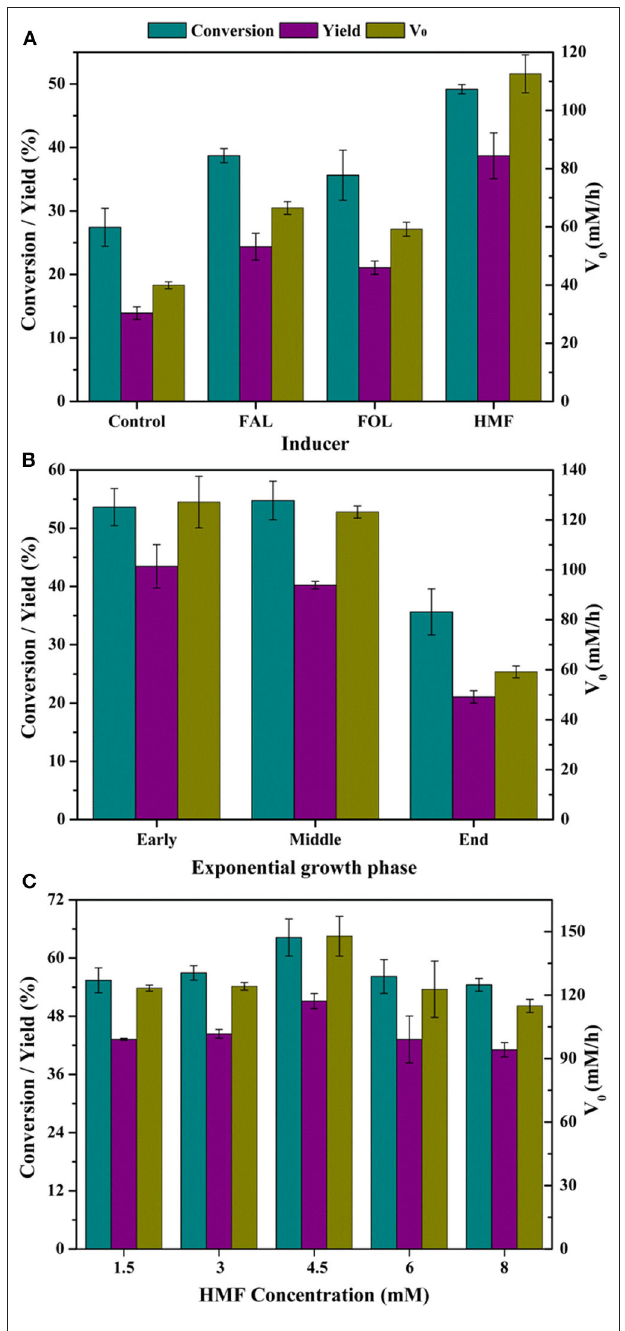
FIGURE 1 | Effect of induction on catalytic performances of P. putida KT2440. Reaction conditions: phosphate buffer (200mM, pH 7.0), 50mM FAL, 7 g/L cells (dry weight), CaCO 3 at half molar concentration of FAL, 30 ◦ C, 200 rpm, 10min. (A) Various inducers were added with 3mM at the early exponential growth phase; (B) 3mM HMF was added at different growth phases as inducer; (C) HMF was added with designated concentrations at the middle exponential growth